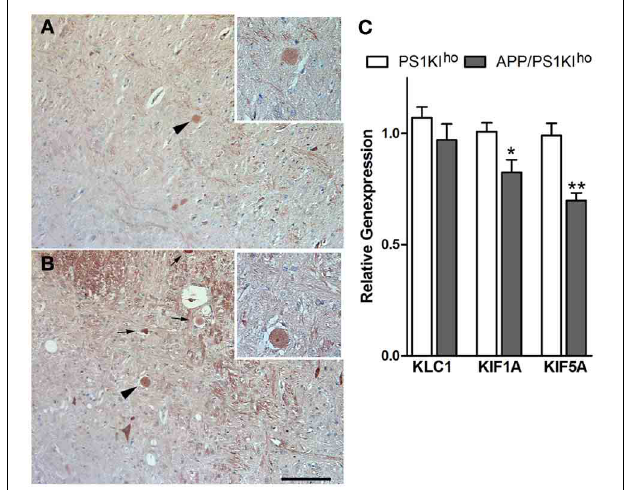
FIGURE 9 | KLC1-positive axonal spheroids (arrows) in 10-month-old APP/PS1KI he (A) and APP/PS1KI ho mice (higher magnification of spheroid indicated by arrowhead in inset). RT-PCR analysis of brain mRNA levels of kinesin family members revealed significantly reduced expression of KIF1A ( p < 0 . 05) and KIF5A ( p < 0 . 01) in APP/PS1Ki ho mice compared to PS1KI ho control mice (C) . All error bars represent